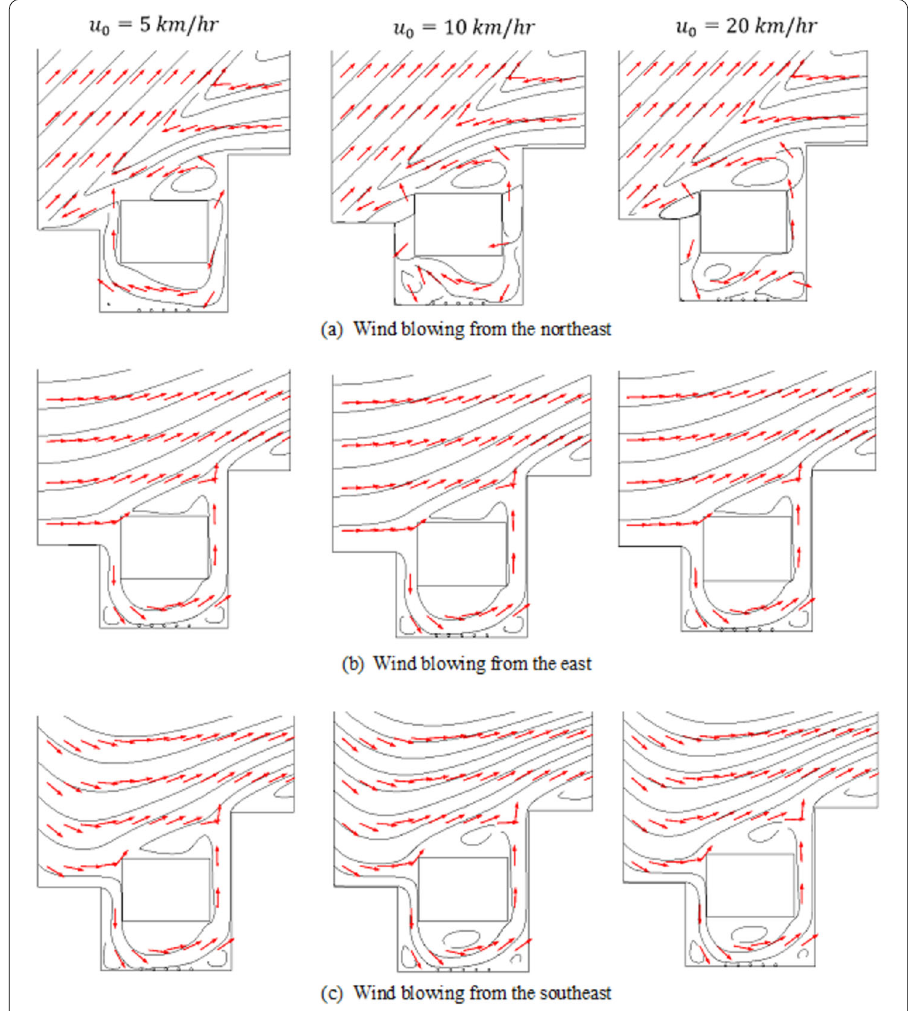
Figure 4 Velocity field and streamlines of wind obtained from the model with various features of inlet wind: wind speed of 5 km/h (first column), 10 km/h (second column), and 20 km/h (last column); and the wind blowing towards 3 different directions: ( a ) northeast; ( b ) east; ( c )